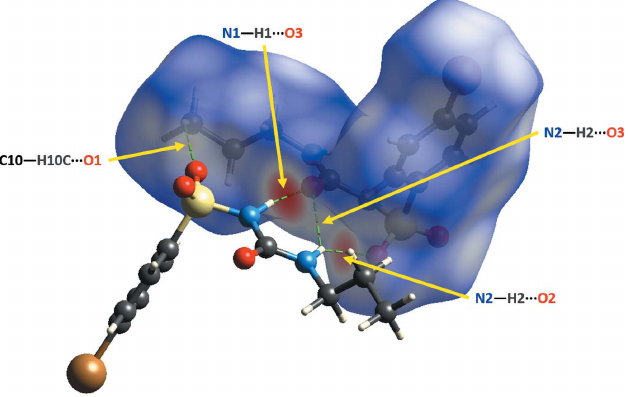
Figure 5 The two-dimensional fingerprint plots of 4-bromo- N -(propylcarbamo- yl)benzenesulfonamide with their relative contribution to the Hirshfeld surface. The units of d i and d e are A˚